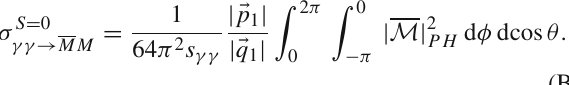
Scalar monopole pairs produced by the DY digram shown whicharederivedanalogouslytothePFcase.Thetotalmatrix